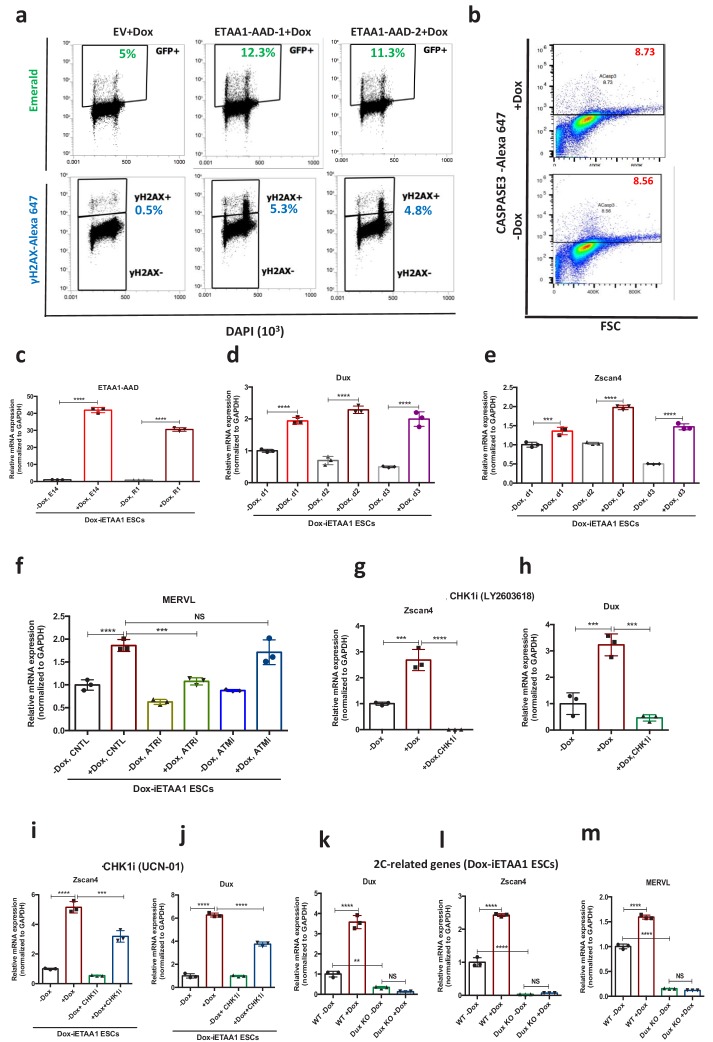
Characterization of ETAA1-AAD inducible ESCs.(a) FACS analysis for γH2AX and Emerald upon overexpression of ETAA1-AAD by Dox in two different lentivirus clones with respect to empty vector (EV)-infected ESCs. (b) FACS analysis of CASPASE-3 in Dox-iETAA1 ESCs. (c) RT-qPCR analysis for the expression of ETAA1-AAD in Dox-iETAA1 ESCs (E14 and R1) upon Dox treatment. (d, e) RT-qPCR results for Dux and Zscan4 expression in Dox-iETAA1 ESCs after 24, 48 and 72 hr of Dox administration (f) RT-qPCR results for MERVL element in Dox-iETAA1 ESCs upon Dox administration in the presence or absence of ATRi or ATMi. (g–h) RT-qPCR results for 2C-related genes, Zscan4 and Dux in Dox-iETAA1 ESCs upon Dox and CHK1i treatment. (i–j) RT-qPCR analysis for Zscan4 and Dux expression in Dox-iETAA1 ESCs in the absence or presence of Dox and CHK1i (LY2603618). (k–m) RT-qPCR analysis for the expression of 2C-related genes in Dox-inducible Dux KO ESCs in comparison with WT ESCs upon treatment with Dox. Statistical significance compared to CNTL unless otherwise indicated. (*p≤0.05, **p≤0.01, ***p≤0.001, ****p≤0.0001, one-way ANOVA).